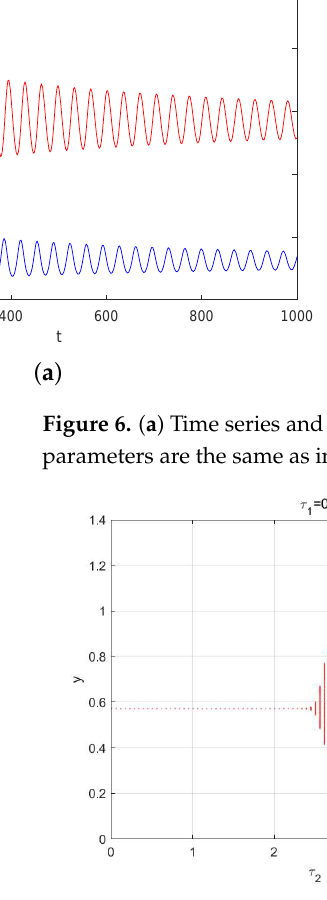
Figure 7. The Hopf bifurcation diagram of (1) for τ 2 and τ 1 =